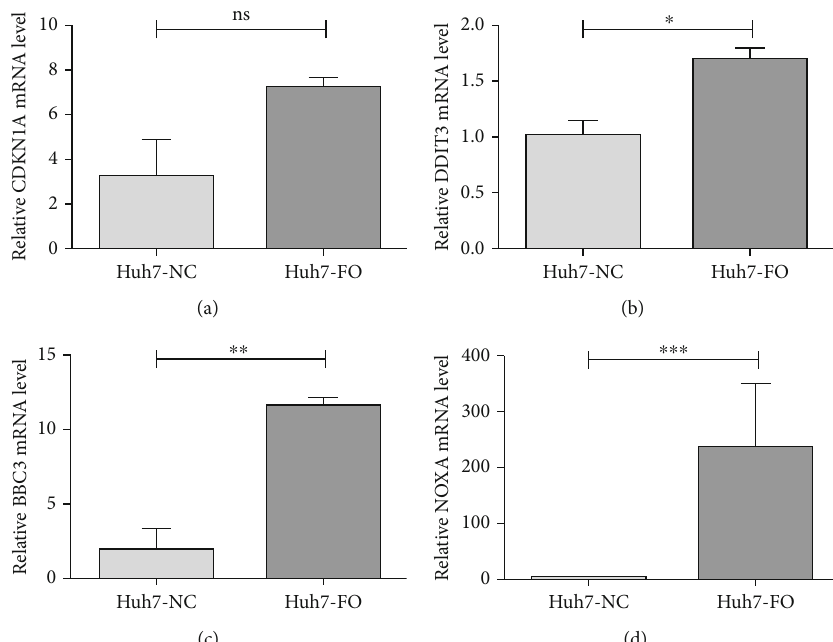
Figure 6: Real-time Q-PCR validation of RNA-Seq data. BBC3, DDIT3, CDKN1A, and NOXA. Results are presented as means ± SEM ; n = 3 . Statistical comparison by Student ’ s t -test: ∗ P < 0 : 05 ; ∗∗ P < 0 : 02 ; ∗∗∗ P < 0 : 01 .